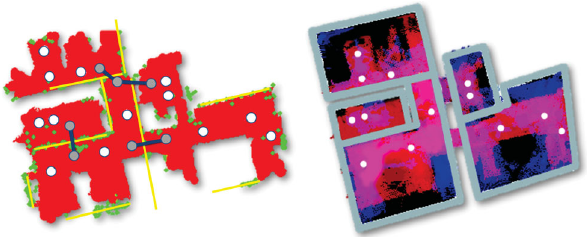
Multi-room environment (D2 dataset; for simplicity we show only floor facets as background). Left: we arrange the images (positions in white) in different rooms by grouping them. We exploit 3D features (green dots) to estimate strong occlusions between poses (yellow lines) and breaks in the camera trajectory (blue segments). Poses too close to the occlusions are discarded (grey poses). Right: having grouped images, each room shape is recovered by projecting only the related images (3D reconstruction shown in Fig.